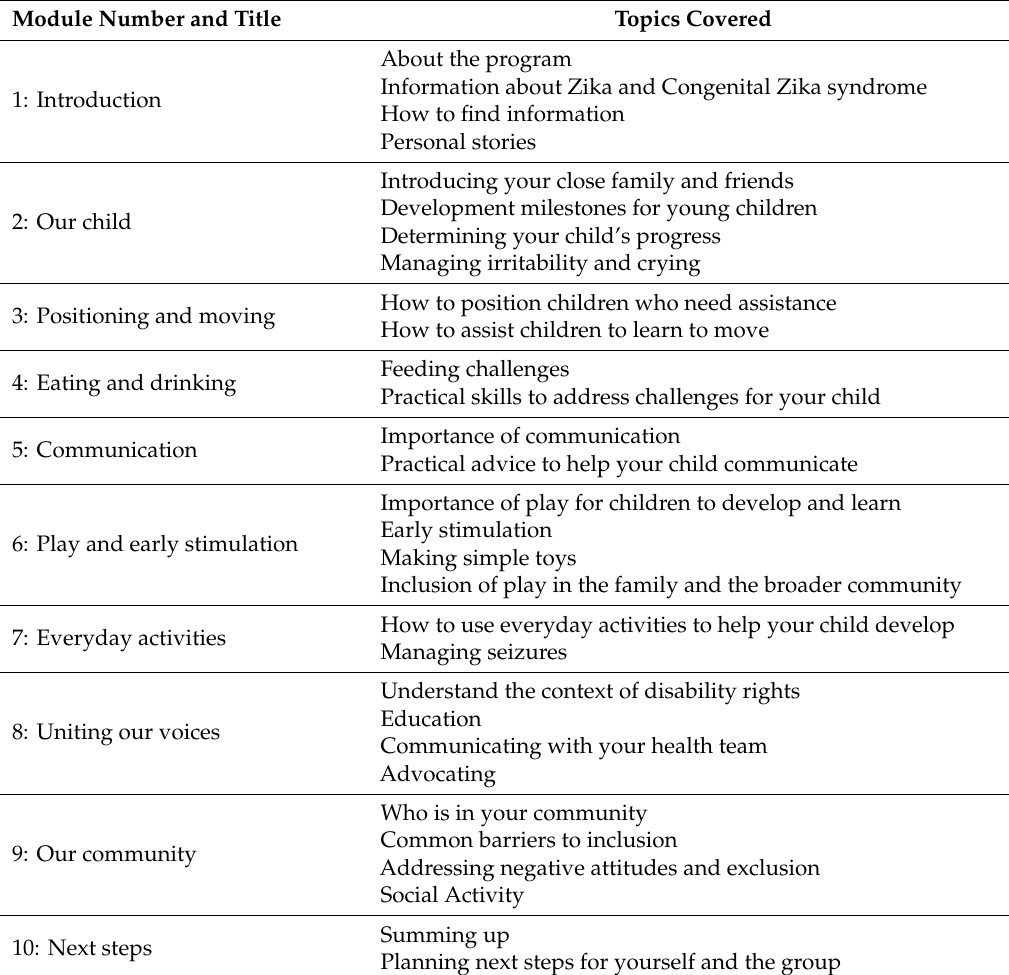
Table 1. Juntos intervention module